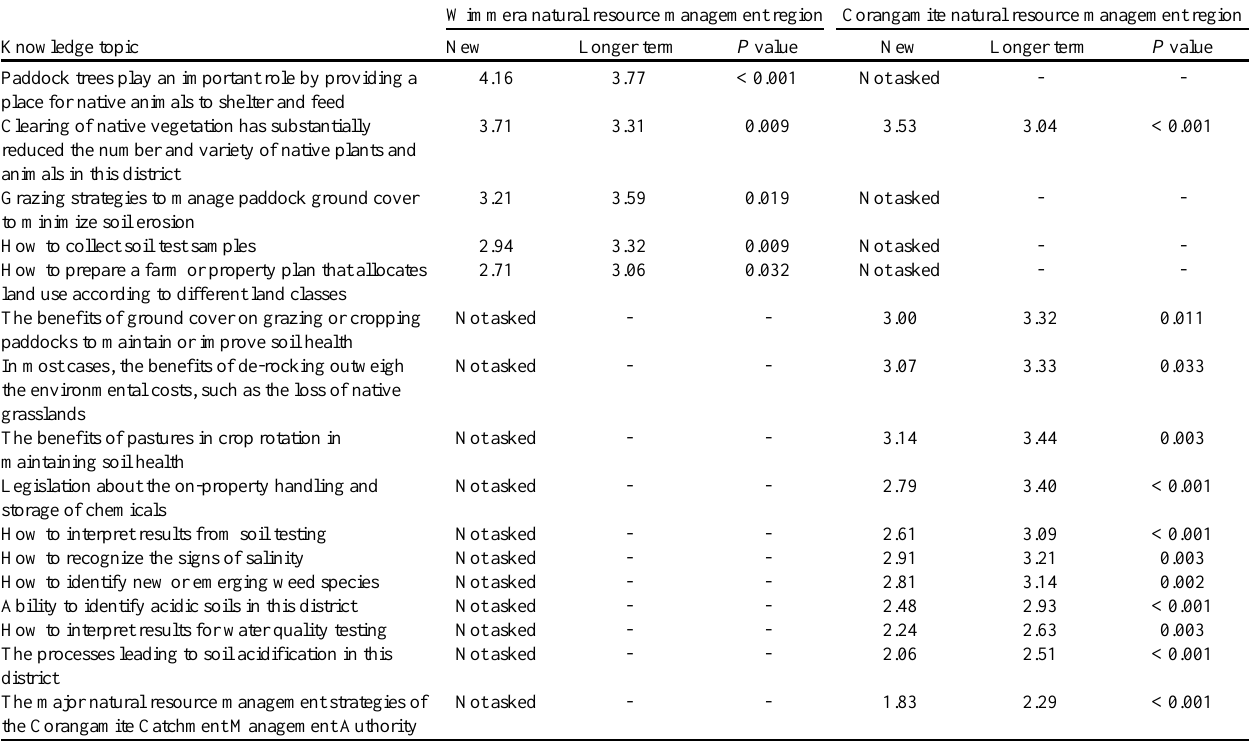
Table 4 . Comparing newer (Wimmera region: n = 66–70; Corangamite region: n = 85–89) and longer term (Wimmera region: n = 358–398; Corangamite region: n = 315–359) landholders: knowledge. ( n denotes the number of respondents. Each item had a different number of respondents owing to missing values; these are indicated by the ranges in n